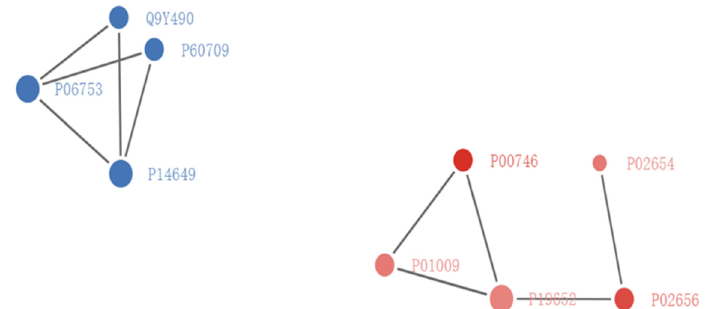
Figure 6. PPI network for DEPs interactions with three genes is extracted through STRING databse confidence cutoff of 0.900 (https://string-db.org/, accessed on 26 January 2021). The interaction network is reconstructed by using the Cytoscape software. The circles represent the differentially expressed proteins. Different colors represent the DEPs (blue is the down-regulated protein and red is the up-regulated protein). The size of the circle suggests the number of DEPs and their interacting proteins. In this study, we screened the top 50 proteins with the closest interaction and mapped the protein interaction network.